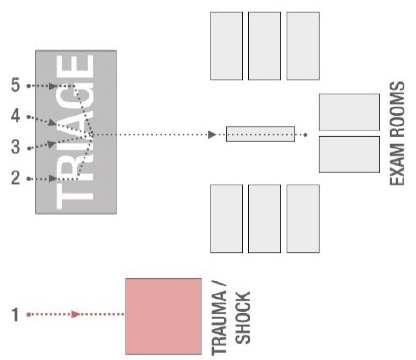
Figure 4. FSED based Triage and Layout Organization.